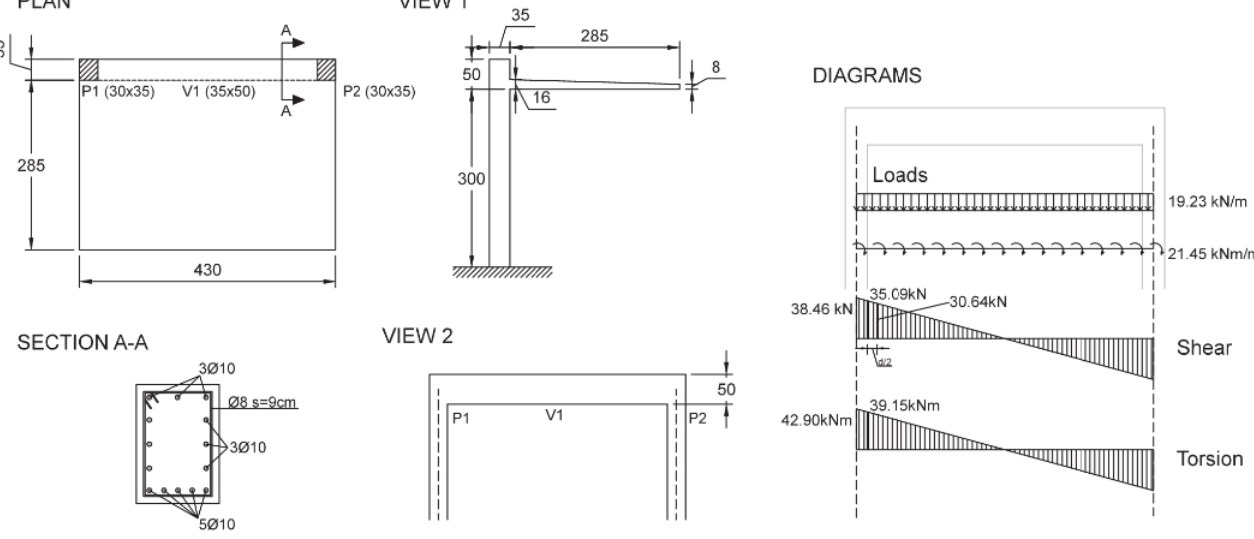
Figure 7 Beam V1 from Example